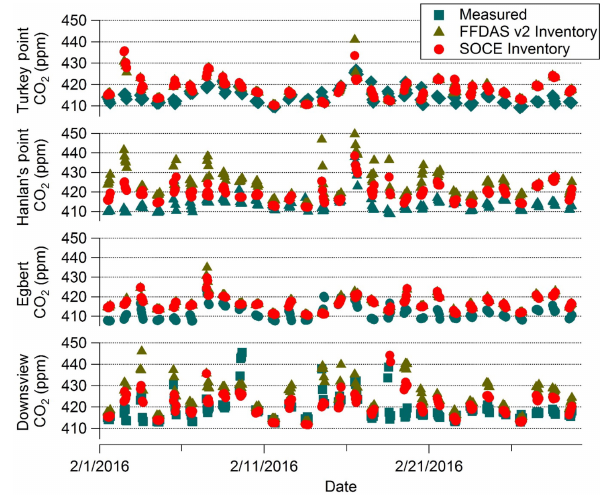
Figure 4. Time series of measured (blue) and modelled February afternoon (12:00–16:00EST) CO 2 mixing ratios for the four sites used in this study. The red and gold markers are the modelled mix- ing ratios when using the SOCE CO 2 inventory and the FFDAS v2 inventory,